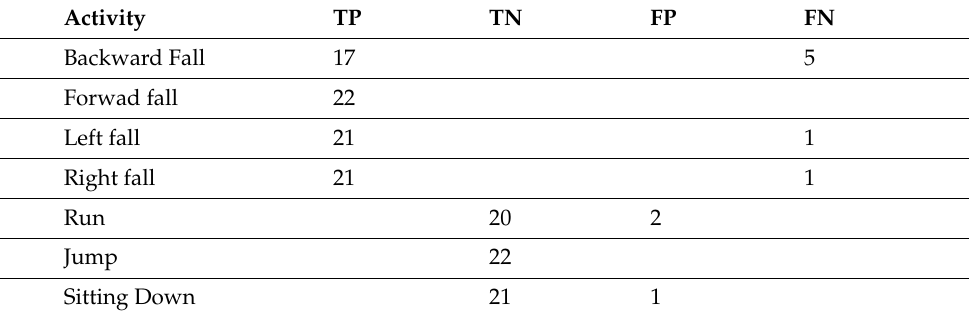
Table 2. Table with the results of the tests grouped by